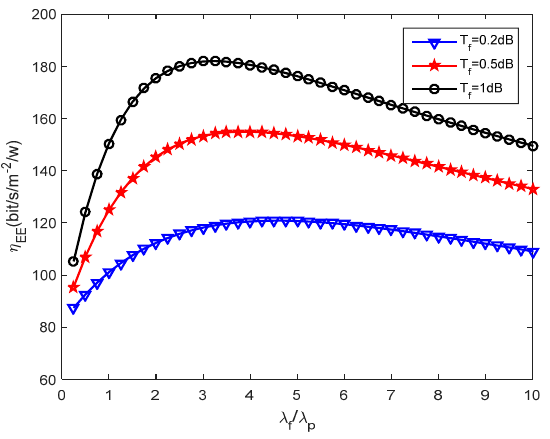
Figure 6. Energy efficiency vs. SBS density ratio when T p = 5.5 dB.